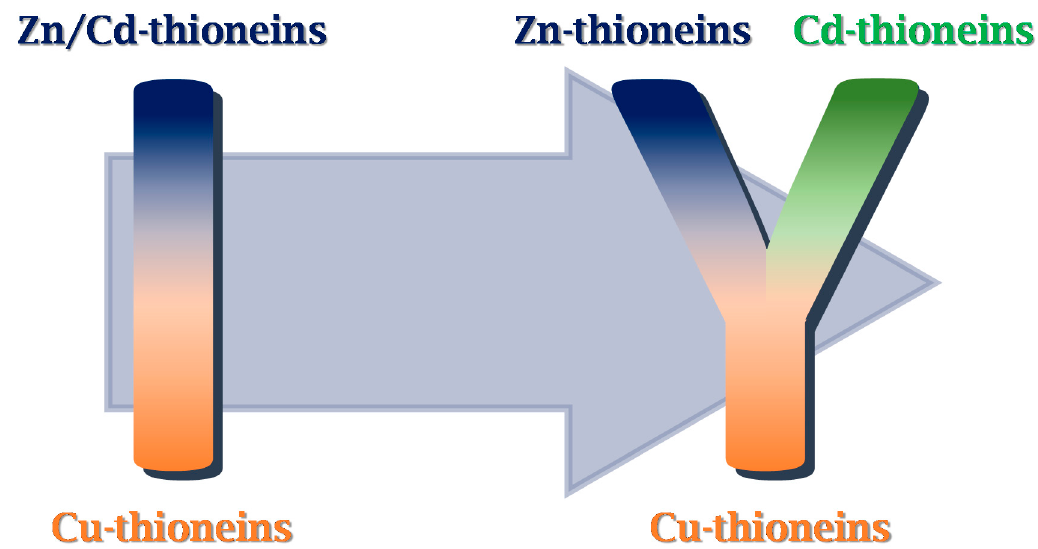
Figure 6. Scheme of the new MT classification proposal that considers the differentiation between genuine Zn- and Cd-thioneins, replacing an “I” disposition to a “Y” setting.